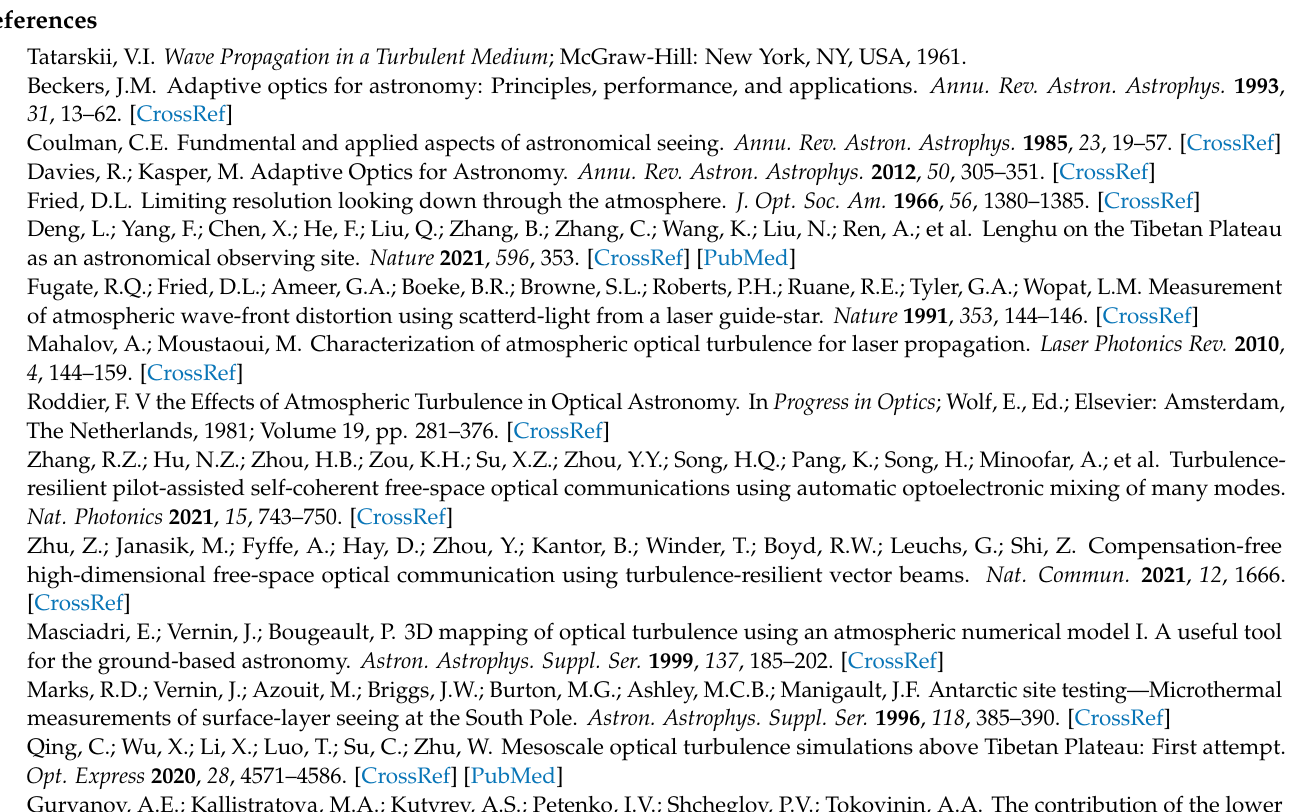
Table A10. NCACN integrated astronomical parameters details ( σ 2